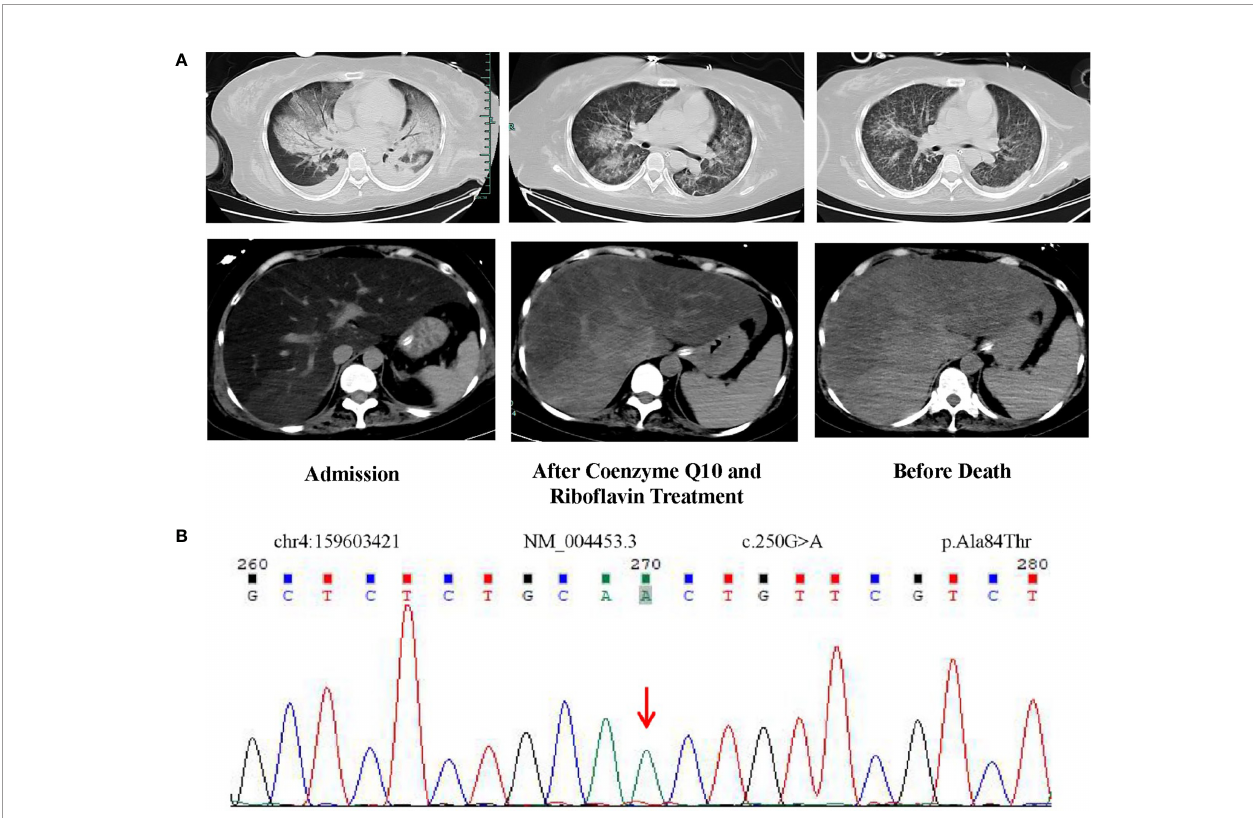
FIGURE 1 | (A) CT images of the lungs and abdomen on admission, after coenzyme Q10 and ribo fl avin treatment, and before death. After treatment with ribo fl avin and coenzyme Q10, the CT value of the patient ’ s liver gradually increased from -40 Hu at the beginning to nearly normal. (B) Homozygous mutation of ETFDH gene (c.250G>A) identi fi ed by whole exome